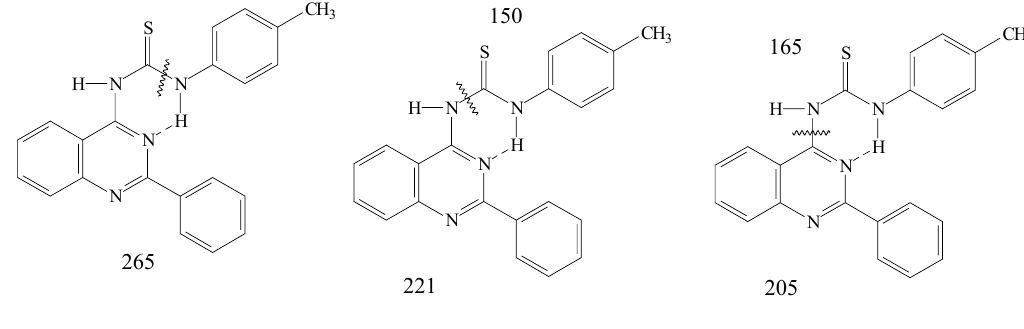
Figure 1. Mass spectral fragmentations of 7g